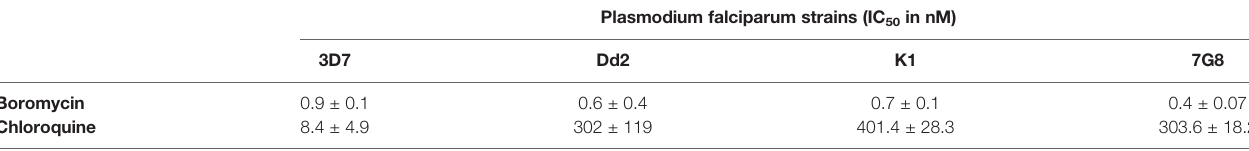
TABLE 3 | Antiplasmodial activity of boromycin against different P.falciparum chloroquine-resistant strains in comparison to 3D7 after 3 days of incubation.